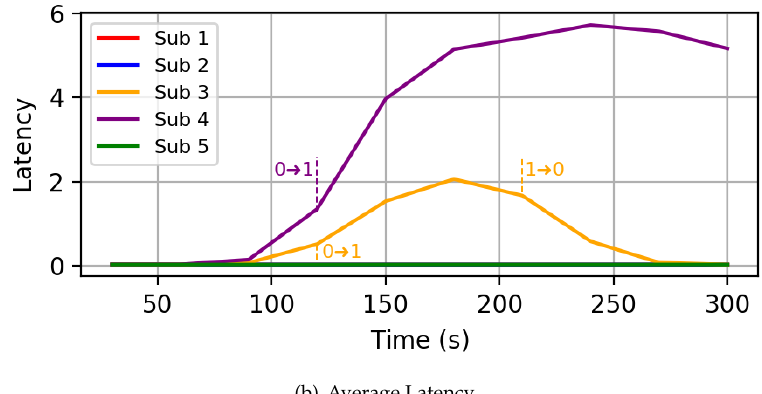
Figure 11. Hitrate-constrained mode scenario.